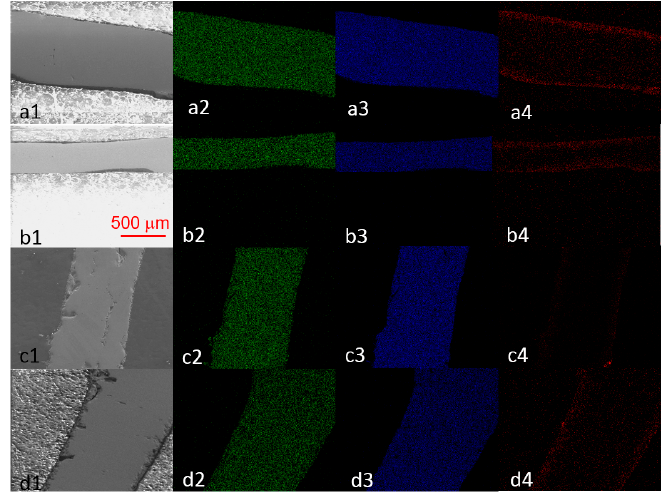
Figure 6. ( a1 , b1 , c1 , d1 ) SEM-BEIs and elemental mappings of ( a2 , b2 , c2 , d2 ) La, ( a3 , b3 , c3 , d3 ) Ni, and ( a4 , b4 , c4 , d 4) Mg of the 4 h-, 8 h-, 16 h-, and 32-h annealed samples, respectively. Table 1. Chemical compositions (in at%) from spots Y1 to Y13 of the 8-h annealed sample (Figure 2).